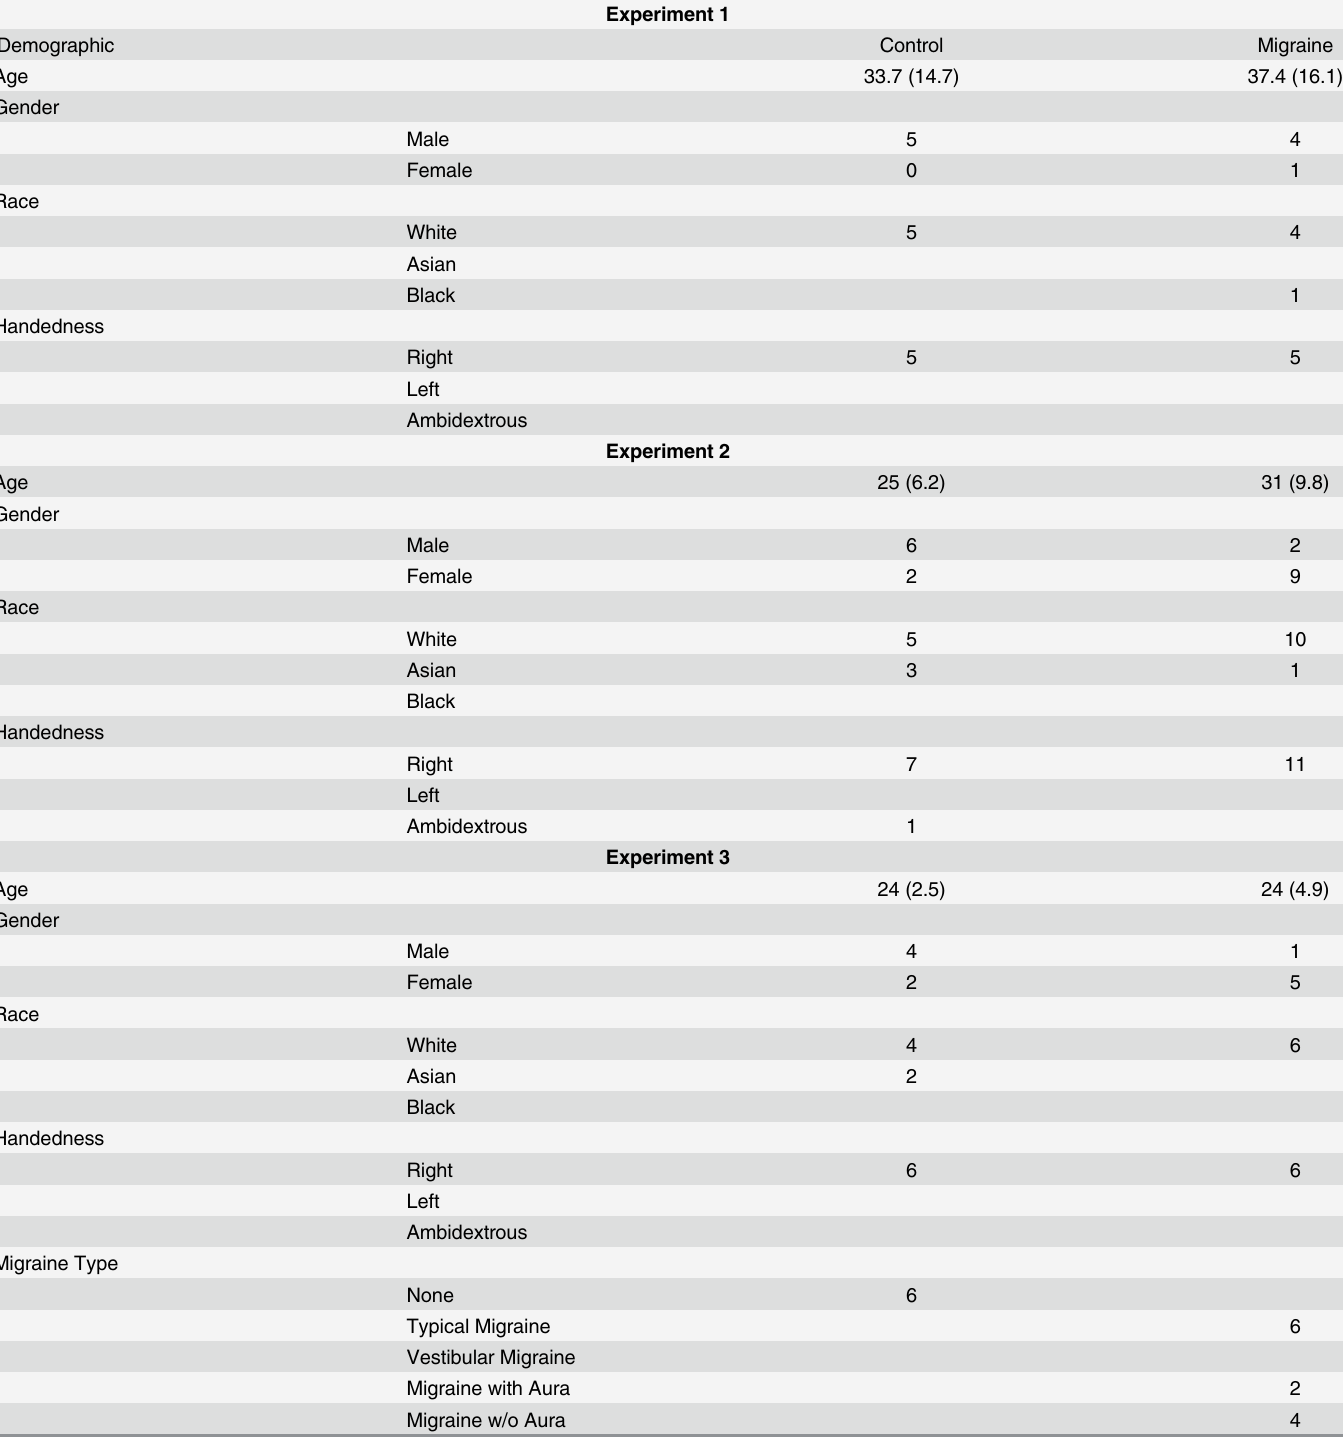
Table 1. Demographic data for experiments 1 – 3. Values in parenthesis represent standard